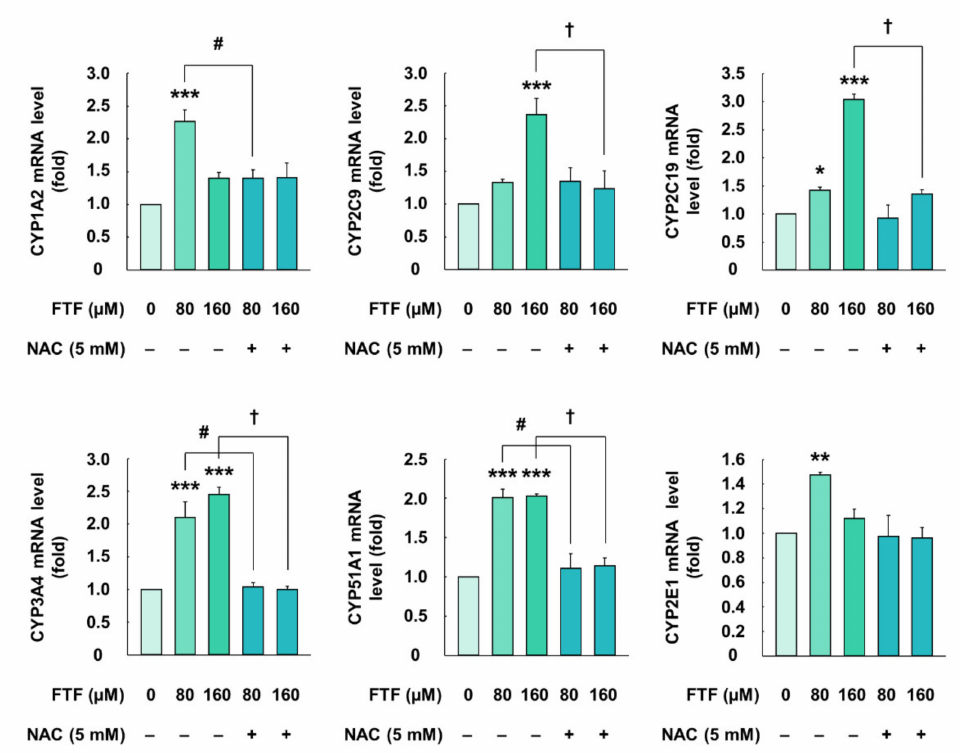
Figure 2. Effects of FTF on gene expression of CYP1A2, 2C9, 2C19, 3A4, 51A1, and 2E1 in HepG2 cells. The cells were treated with 80 and 160 µ M FTF for 24 h with 5 mM NAC pretreatment for 1 h ( n = 3 wells per group). GAPDH was used as the housekeeping gene. The results are expressed as mean ± SEM and statistically significant differences, compared to the control (DMSO), are indicated as * P < 0.05, ** P < 0.01, and *** P < 0.001. # P < 0.05 and † P < 0.05 indicate a significant difference, compared to the 80 and 160 µ M FTF treatment groups, respectively. Abbreviations: FTF, flutriafol; CYP, cytochrome P450; NAC, N-acetylcysteine; GAPDH, glyceraldehyde 3-phosphate dehydrogenase; SEM, standard error of mean; DMSO, dimethyl